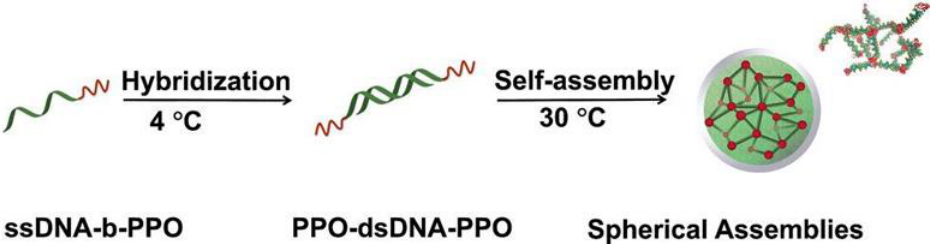
Figure 4. Illustration of the preparation and self-assembly of supramolecular triblock copolymer PPO-dsDNA-PPO. The coil-rod-coil supramolecular triblock copolymer PPO-dsDNA-PPO was firstly generated by DNA base pairing interaction at low temperature. Then by elevating the temperature, the triblock copolymers spontaneously assembled into large spherical micelles. The green chain represents DNA strand and the red chain represents PPO polymer. Reproduced with permission from the authors of a previous paper [64]. Copyright 2015 American Chemical Society.